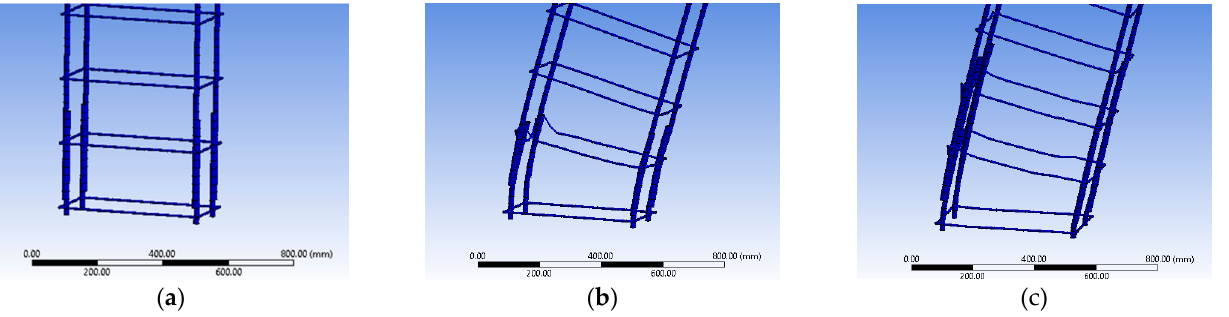
Figure 3. ( a ) Specimen R-P2L1 with 15 d bL lap length, undeformed; ( b ) Slippage of longitudinal steel bars of specimen R-P2L1 at ultimate displacement 58.46 mm; ( c ) Specimen R-P2L3 at ultimate displacement of 66.85 mm (magnification factor 5).